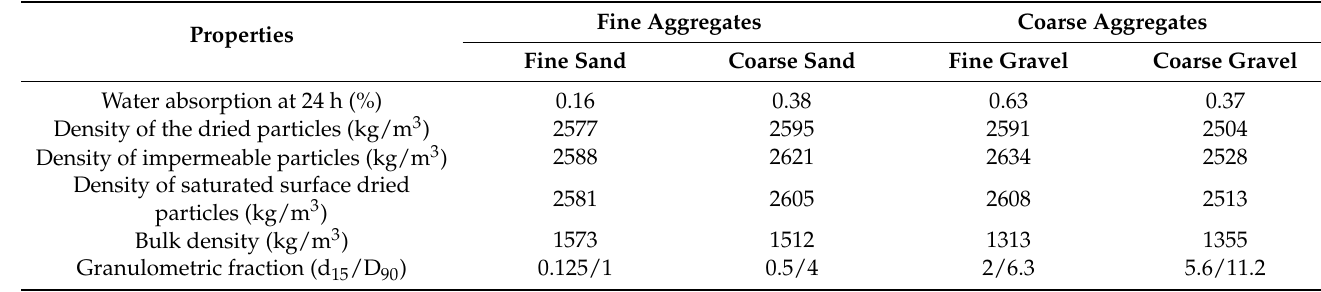
Table 2. Physical characteristics of aggregates.